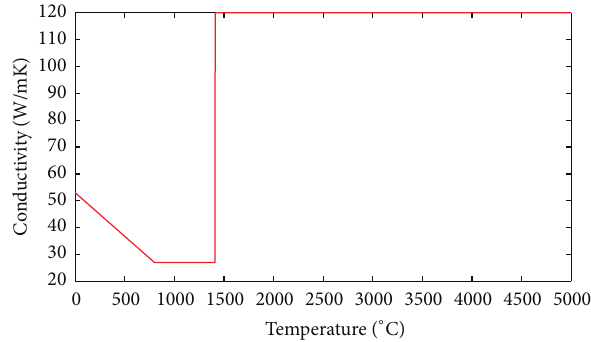
Figure 4: Location and function of the U-piece along with region of interest on the welded